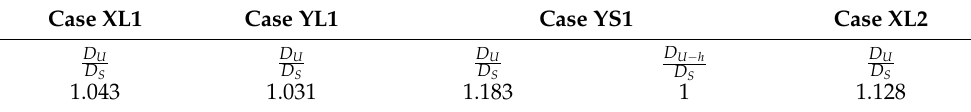
( d ) Figure 10. Inter-story drift ratio when the maximum roof displacement occurred: ( a ) case XL1; ( b ) case YL1; ( c ) case YS1; ( d ) case XL2. 4.2. Inter-Story Displacement In the performance-based seismic design of structures, the inter-story drift ratios must meet the limits specified by the relevant code [44]. The inter-story displacement time histories of each floor of the composite frame with traditional studs and URSP connectors in various cases were obtained, and the partial results of case XL1 are presented in Figure 11. Table 3 shows the maximum inter-story displacements of traditional studs and URSP connectors in various cases. It can be seen from the figure and table that, compared with traditional stud connection, the amplitude of each floor and the time to reach the ampli- tude of the inter-story drift ratio were slightly different after the URSP connectors were arranged. Figure 11. Inter-story displacement time history of case XL1.